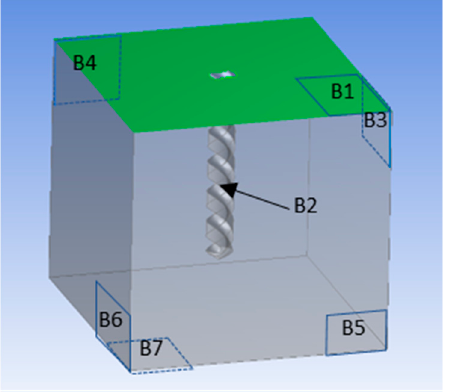
Figure 5. Geometric simulation model of the effect of ultrasonic vibration on gas film.